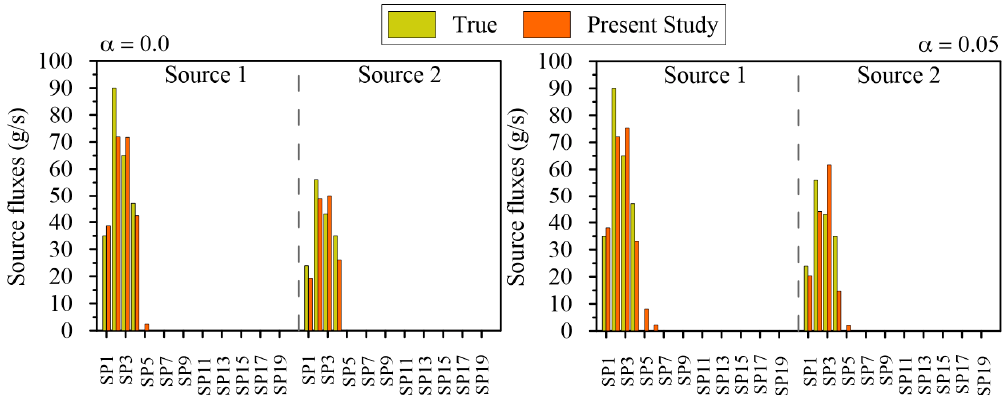
Figure 8. Recovered release histories of sources 1 and 2 in error-free data condition ( α = 0) and in error-perturbed data condition ( α = 0.05).